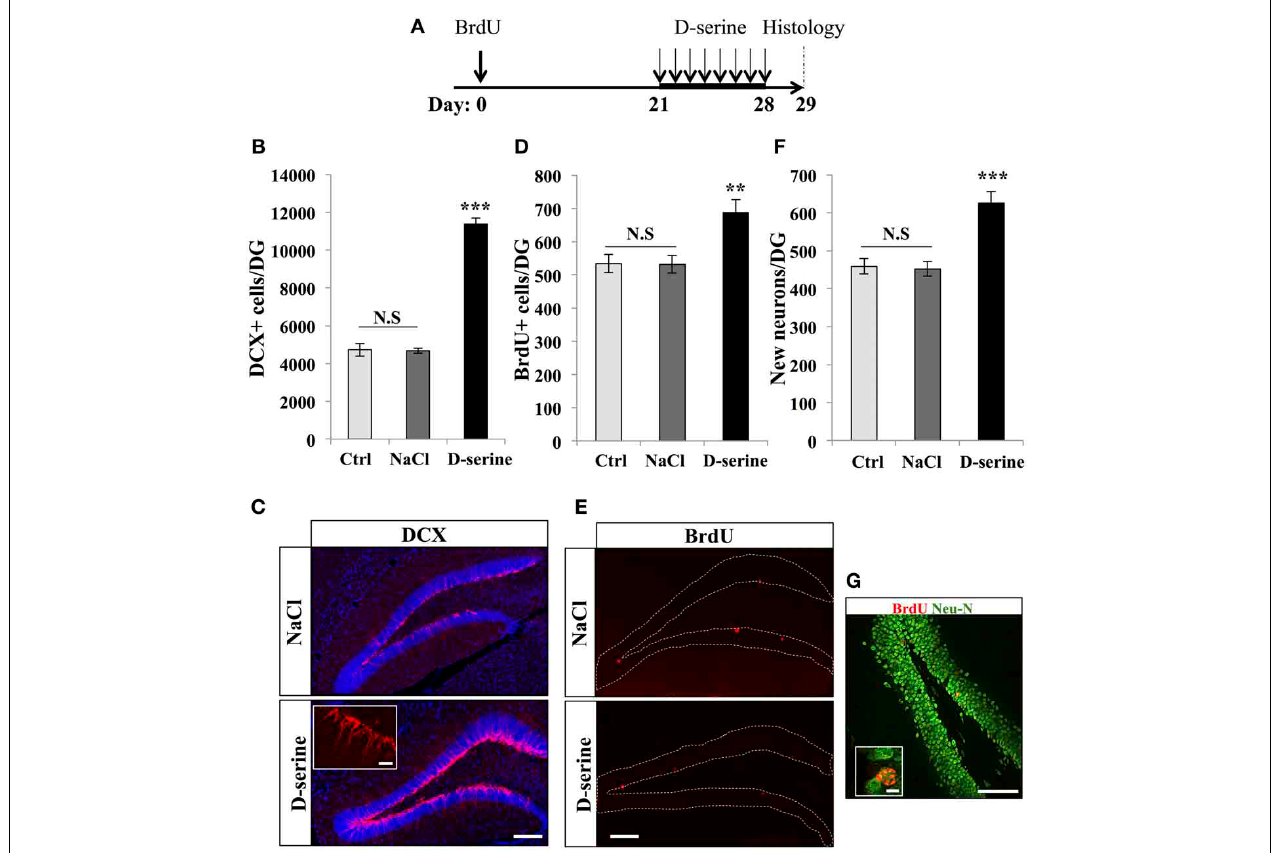
FIGURE 5 | D-serine increased the number of DCX-expressing cells and the survival of new neurons. (A) Experimental timeline: Mice were injected with BrdU (100mg/kg) 3 times at 2h interval. Twenty-one days later, mice received one injection of D-serine (50mg/kg) every day for 8 consecutive days. One day after the last injection, mice were euthanized and prepared for histology. (B) Histogram showing the number of DCX-immunolabeled cells in the dentate gyrus of mice injected with D-serine or NaCl and in control, non-injected animals (Ctrl). Animals: n = 4 per groups. (C) Confocal maximal projection micrographs of hippocampal sections immunostained for DCX from the two experimental groups. Inset: higher magnification micrograph of a DCX-immunolabeled group of cells. (D) Histogram of the number of